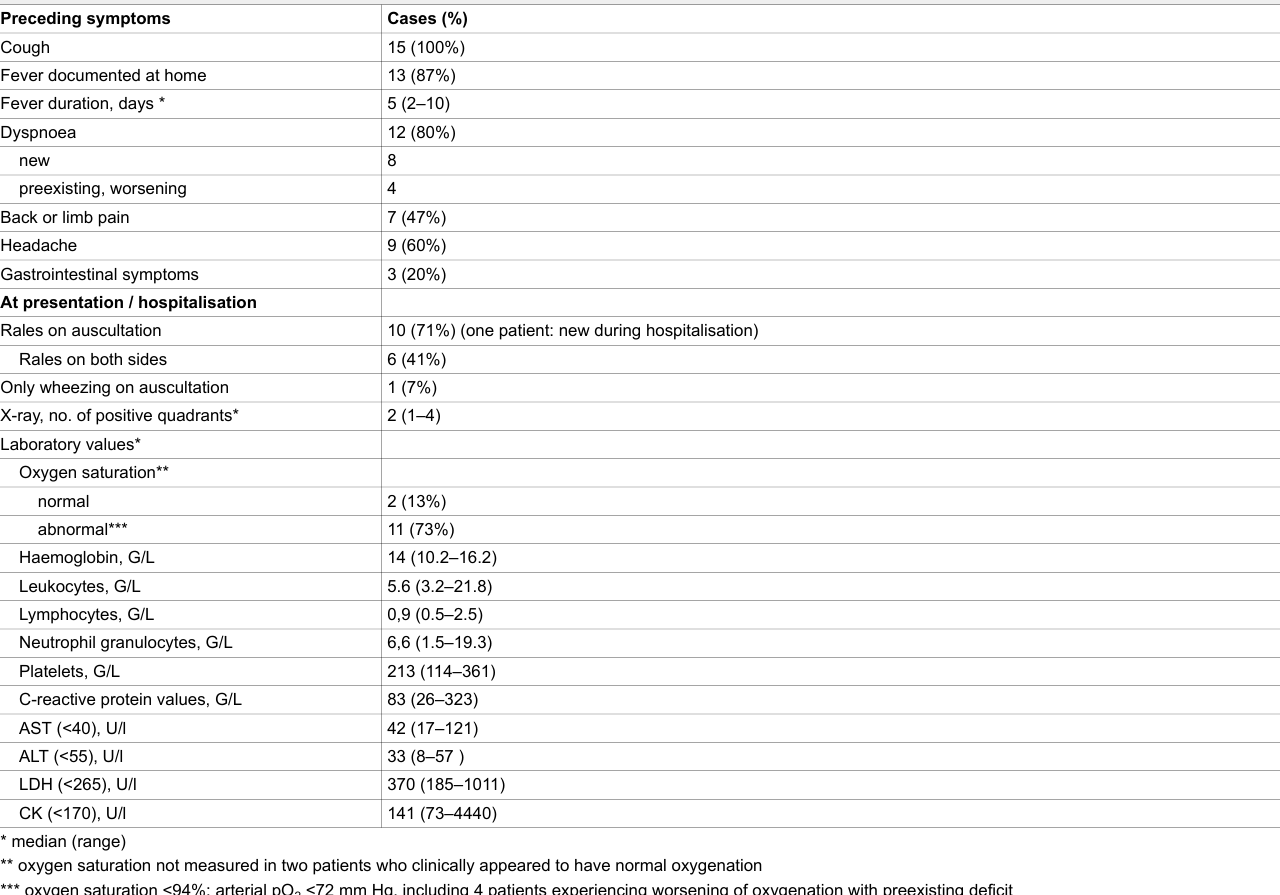
Table 1 Preceding symptoms, signs, x-ray and laboratory at presentation / hospitalisation in all 15 patients with pneumonia.